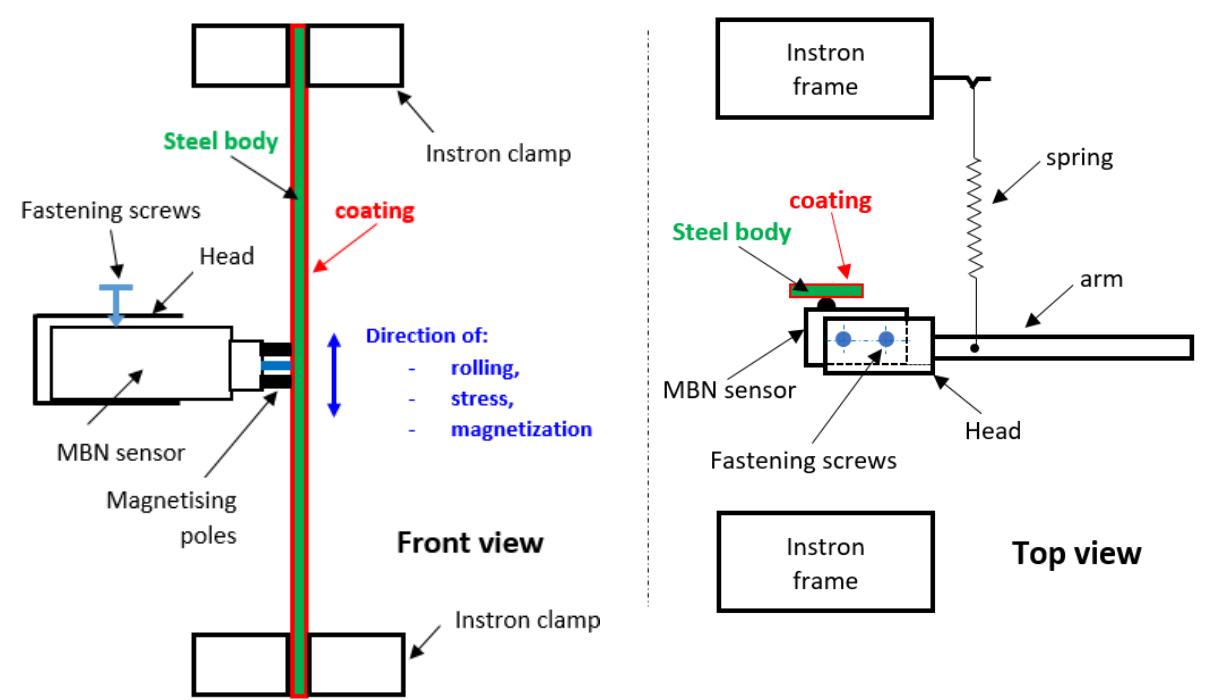
Figure 2. Brief sketch of magnetic Barkhausen noise (MBN) sensor positioning during uniaxial tensile test.